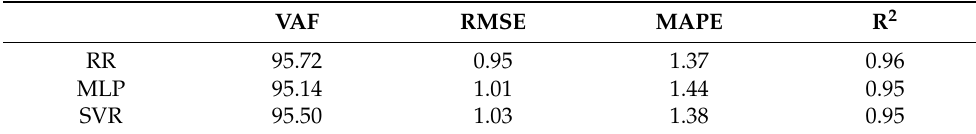
Table 2. Evaluation results of different machine learning algorithms. VAF